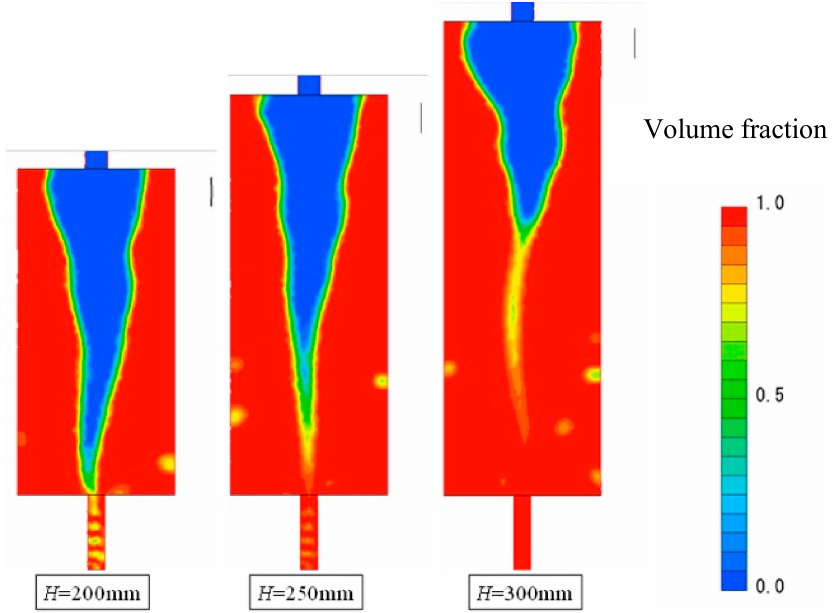
Figure 10. CAE analysis results for volume fraction for different tank heights.